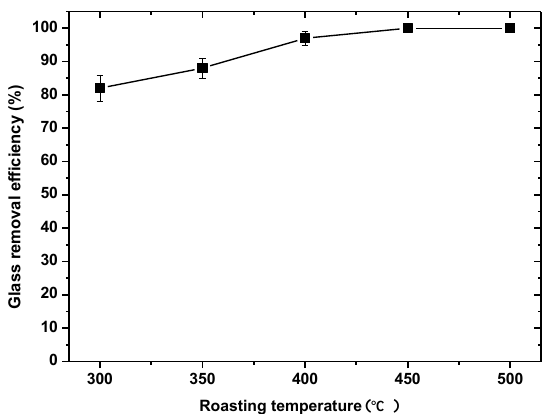
Figure 1. Effect of roasting temperature on glass removal efficiency (experimental conditions: abrasive – glass polishing waste: approximately 1 g; mass ratio of polishing waste to NaOH (sodium hydroxide): 1:1; roasting time: 2 h; water leaching pH: 3; leaching temperature: 25 °C, liquid – solid ratio: 200 mL/g).